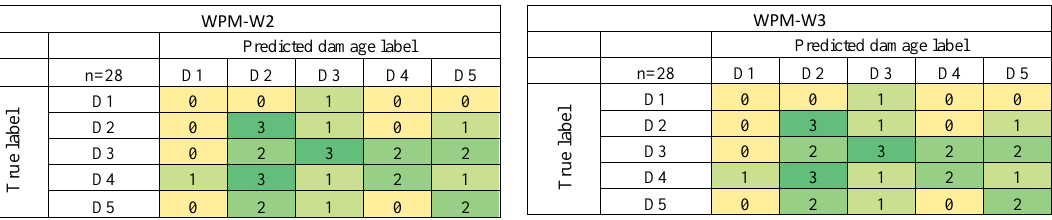
Figure 10. Confusion matrix for Weighted Product Method